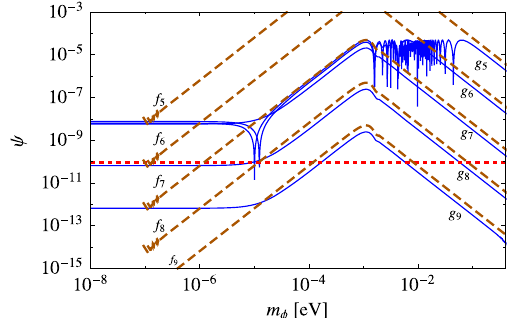
Fig. 2 Comparison of ellipticity effects in the model of ALP-photon (dashed) and the ALP-HP-photon model (solid line). The nomenclature is f i → g φγγ = 10 − i GeV − 1 and g i → g = 10 − i eV − 1 . The bench- mark values used are m γ (cid:4) = 10 − 6 eV, B = 2 . 6 T, χ = 10 − 2 , ω = 1 eV, L = 1 m. Red dotted line corresponds to the experimentally measured value of the ellipticity angle from PVLAS [17], | ψ exp | ≤ 9 × 10 −